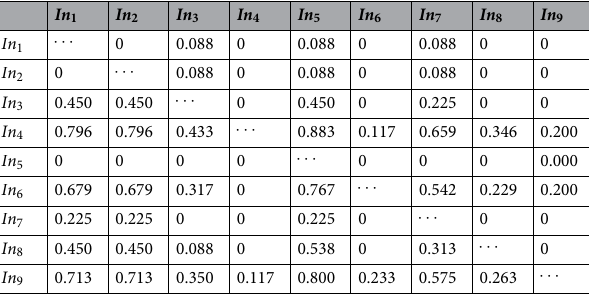
Table 6. Aggregated Preference Value.